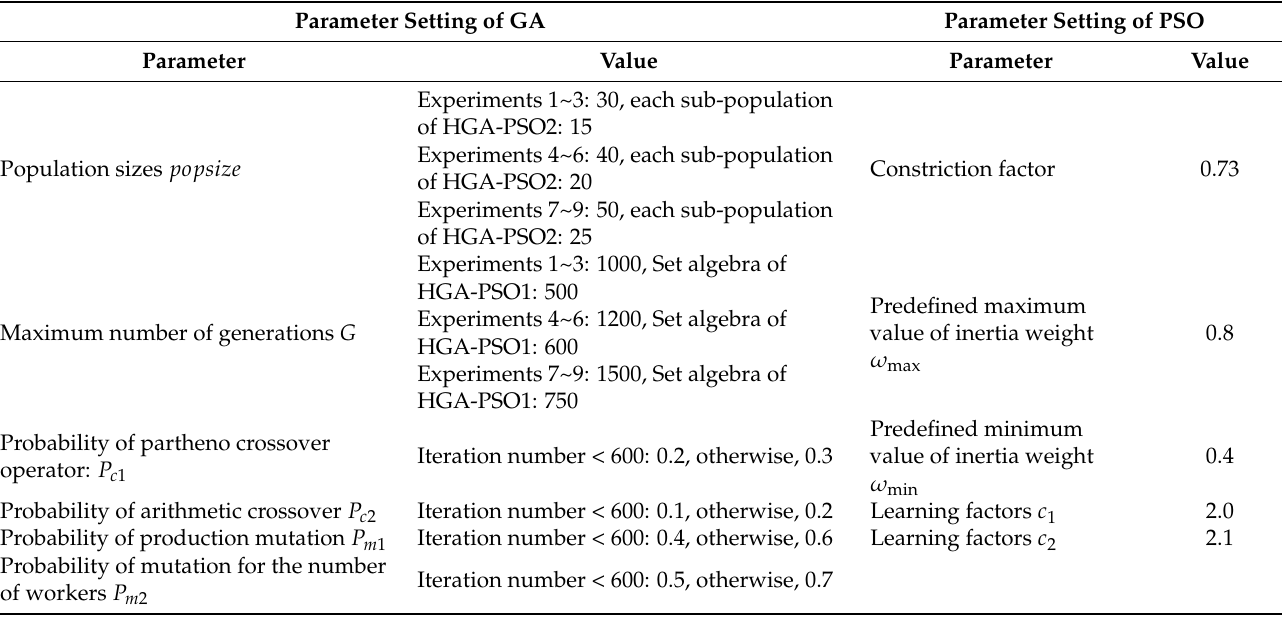
Table 7. Parameters of the GA and